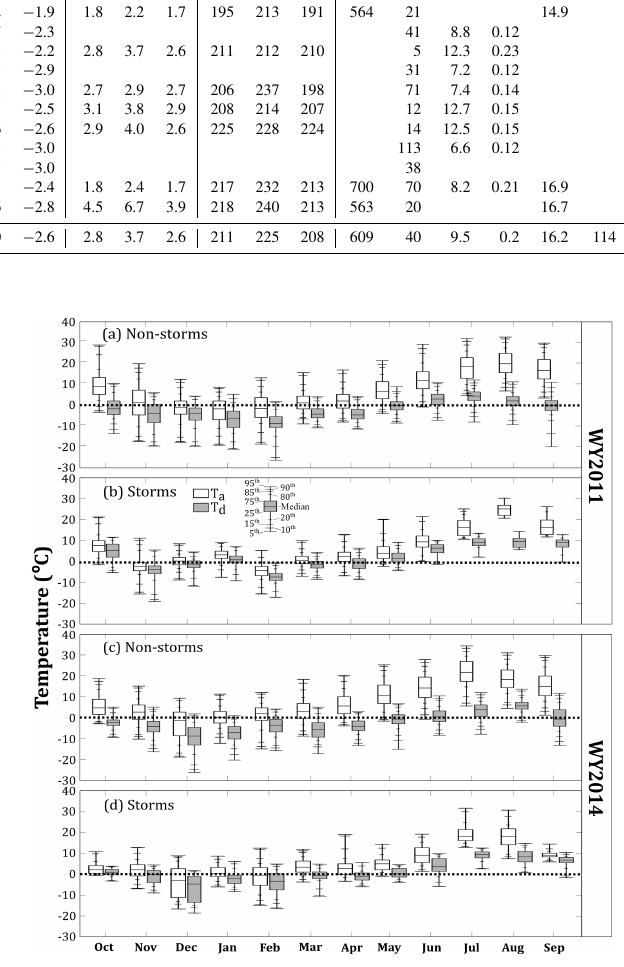
Figure 2. Monthly average T a (white) and T d (grey) during non- storm (a, c) and storm (b, d) periods for WY2011 and WY2014 based on data from all stations. The legend in (b) applies to all pan- els; boxes depict the interquartile range and longest whiskers indi- cate the 5th and 95th percentiles of